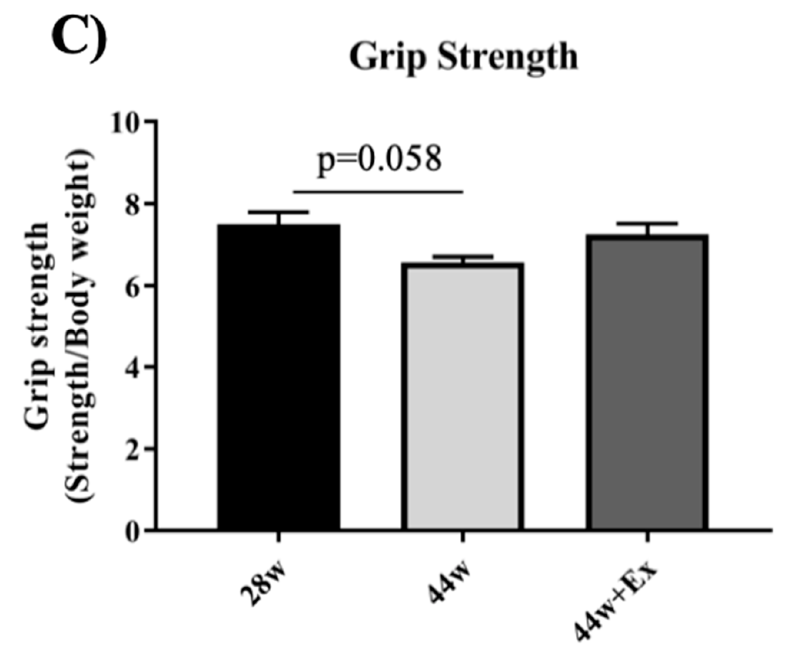
Figure 3. Muscle weight and Grip strength. ( A ) Muscle mass in each group. ( B ) Relative muscle mass. ( C ) Relative Grip strength. Muscle weights were measured at each time point. The grip strength reflected a muscle strength index of all four limbs and was conducted using a small animal grip measurement device. Values are means ± SE ( n = 7–9). Single asterisk indicates significant differences ( p < 0.05).